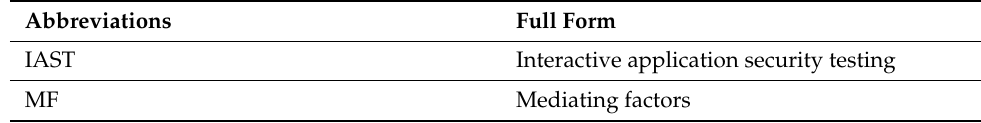
Table 1. List of abbreviations